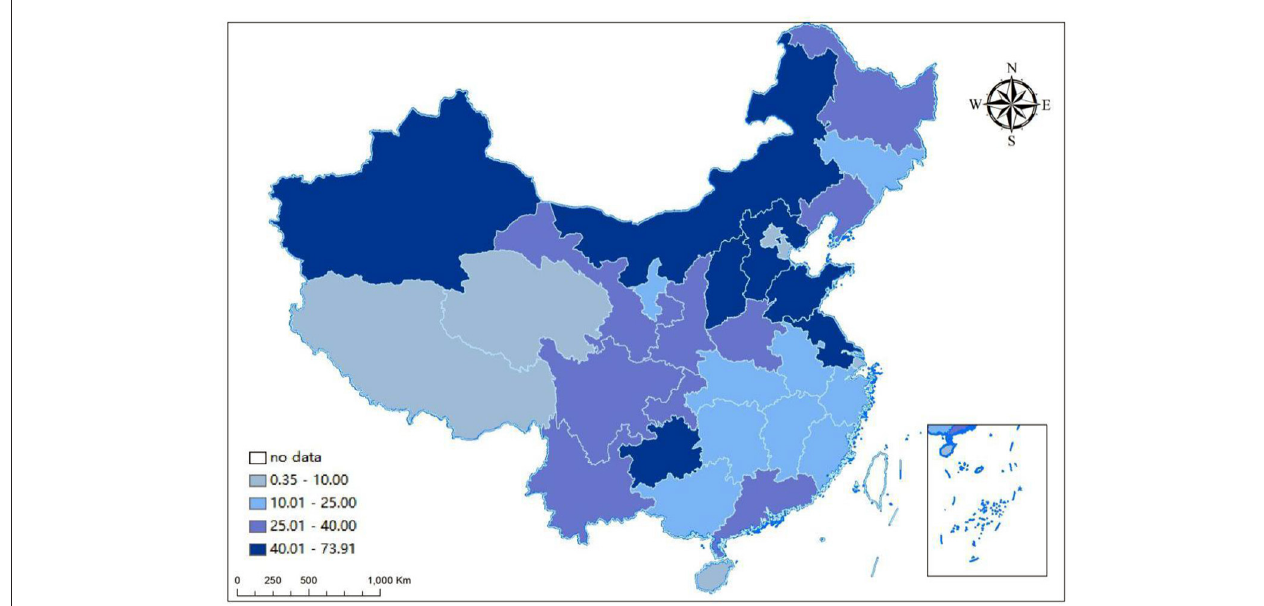
FIGURE 2 | The geographic distribution of SO 2 emissions across provinces and regions in 2017.